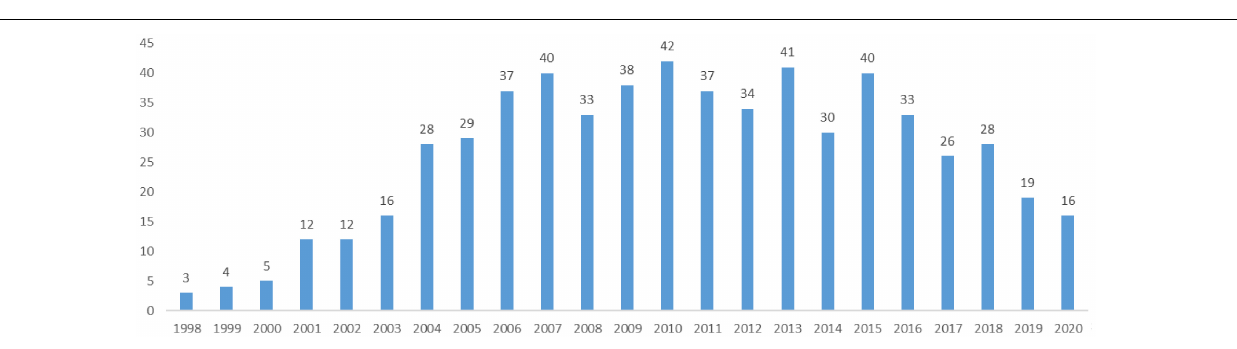
FIGURE 2 | The number of EN papers published in China